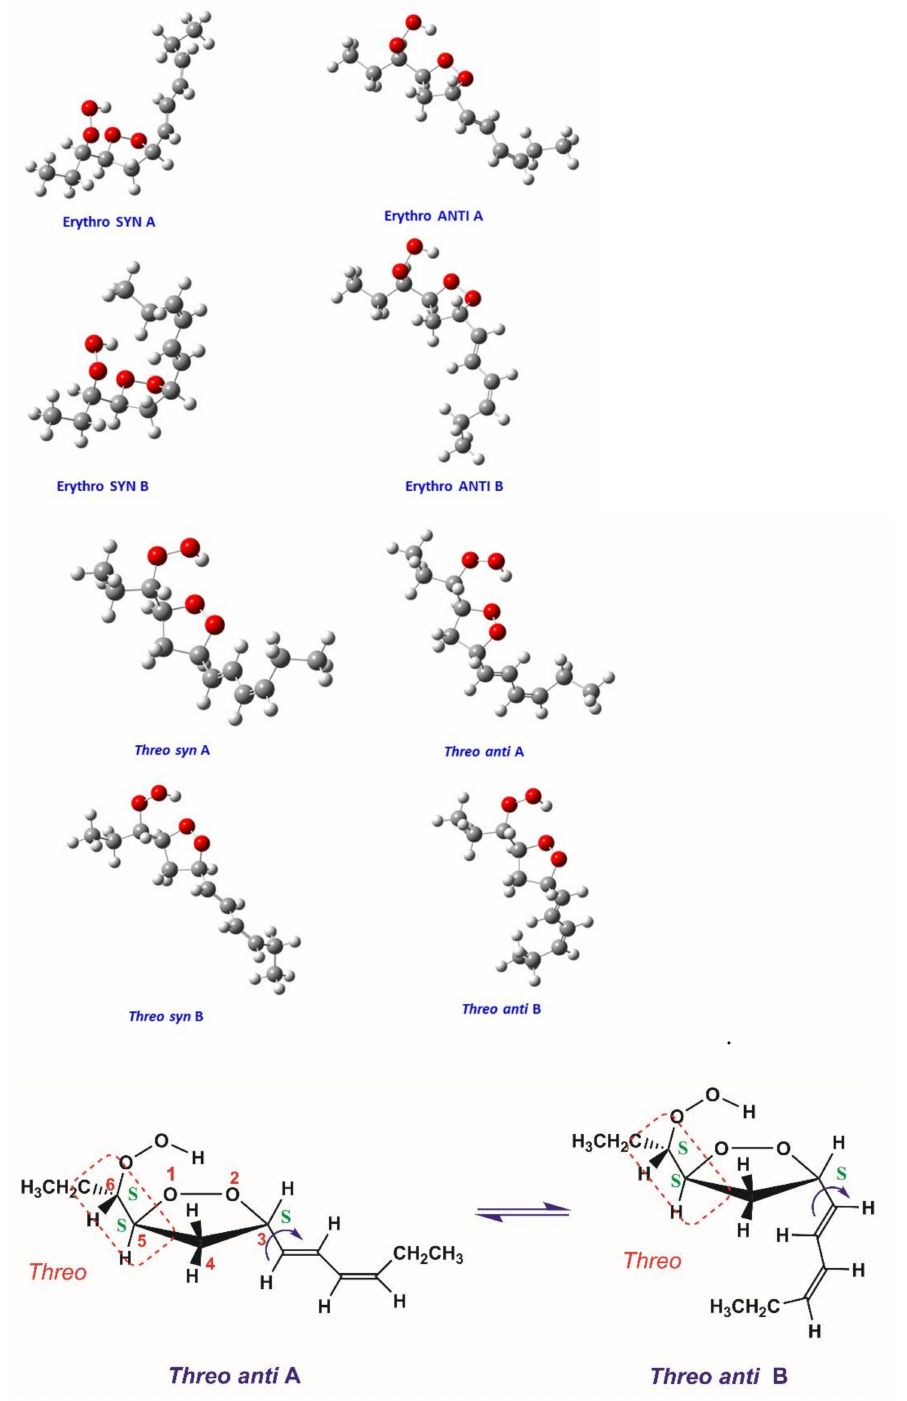
Figure 49. Structures of erythro - and threo -diastereomers of the endo -hydroperoxide with energy minimization at the DFT/B3LYL/6-31+G(d) level. The anti A and anti B conformers of (3S,5S)-3- ((1 E ,3 Z )-hexa-1,3-dien-1-yl)-5-((S)-1-hydroperoxypropyl)-1,2-dioxolanes are shown [141]. Further DFT calculations of various diastereomeric pairs of model endo